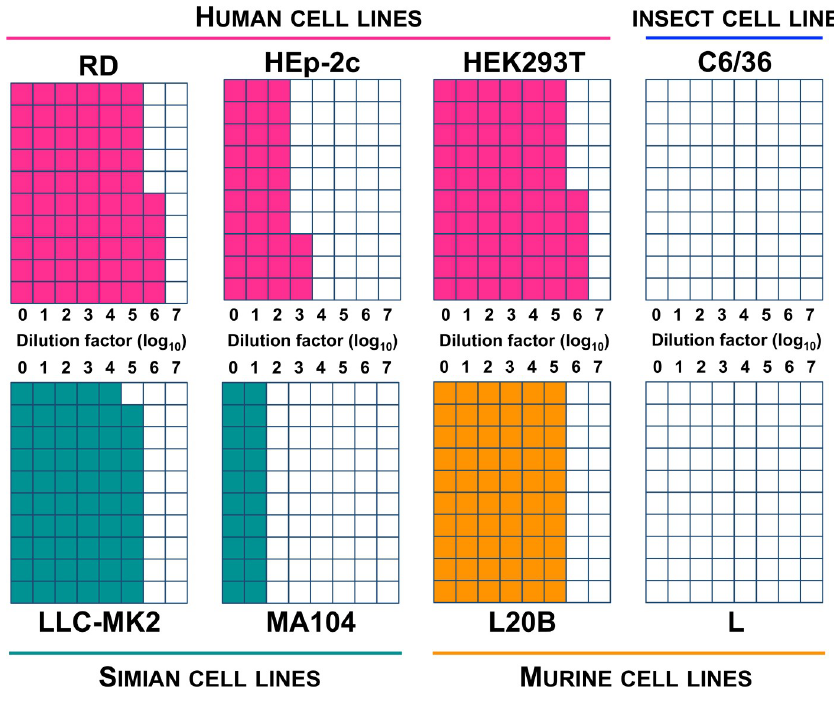
Fig 8. Susceptibility of different cell lines to EV-D111 strain OUP-05-059. Serial 10-fold dilutions of a virus suspension were used to infect cells in 96-well plates (10 wells per dilution for each cell line). Cell monolayers were checked microscopically 6 days post-infection to detect cytopathic effects. For each dilution, the coloured squares indicate the number of wells in which cytopathic effects were